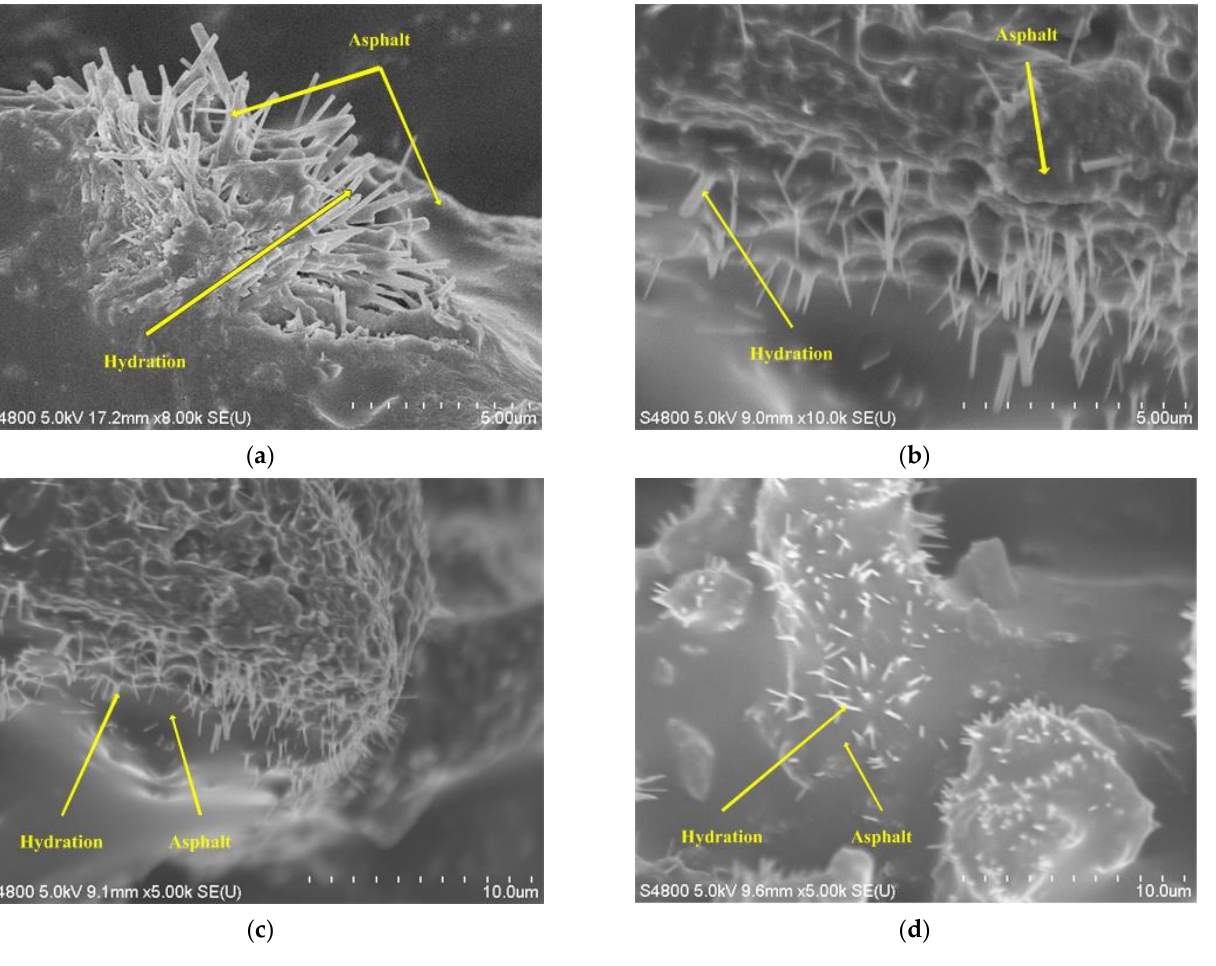
Figure 8. Microstructure of mortar with different freeze – thaw cycles in the complete water satura- tion condition: ( a ) 0 freeze – thaw cycle in 5.0 μm ; ( b ) 10 freeze – thaw cycles in 5.0 μm ; ( c ) 10 freeze – condition: ( a ) 0 freeze–thaw cycle in 5.0 µ m; ( b ) 10 freeze–thaw cycles in 5.0 µ m; ( c ) 10 freeze–thaw thaw cycles in 10.0 μm ; ( d ) 20 freeze – thaw cycles in 10.0 μm . cycles in 10.0 µ m; ( d ) 20 freeze–thaw cycles in 10.0 µ